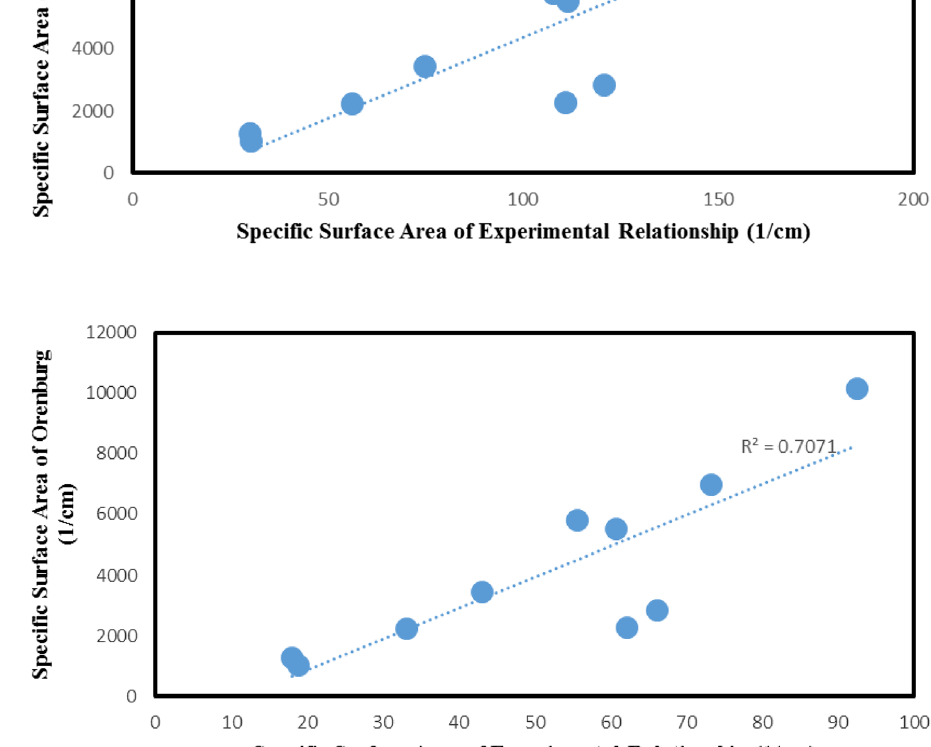
Fig. 13 Specific surface area of Orenburg data versus Kotyak- hov model